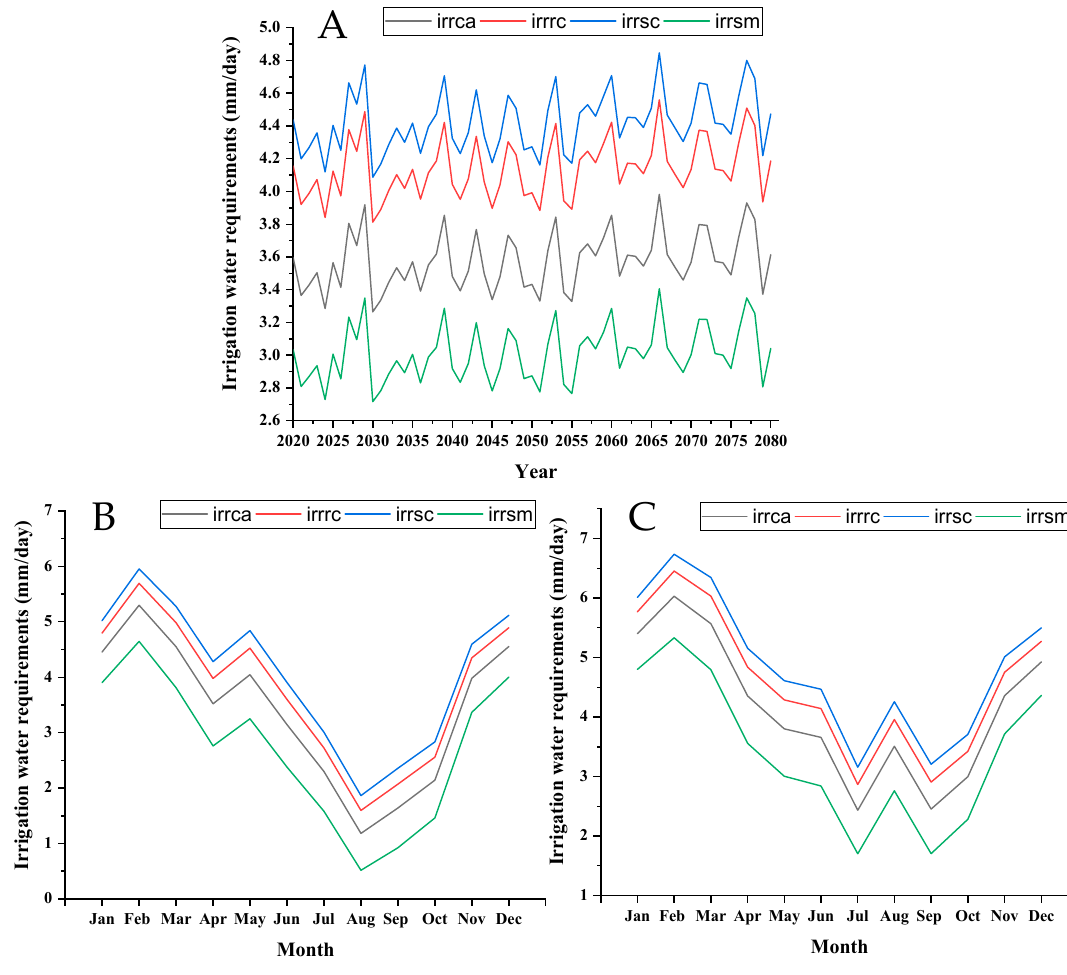
Figure 13. Evolution of IWR (in mm/day) under MIROC 5 RCP 8.5. ( A ) Demonstrates annual irrigation water requirements. ( B ) Demonstrates monthly irrigation water requirements for 2030, with the lowest irrigation water requirements by crops. ( C ) Demonstrates monthly irrigation water requirements for 2066, with the highest irrigation water requirements by crops. Same as Figure 3.